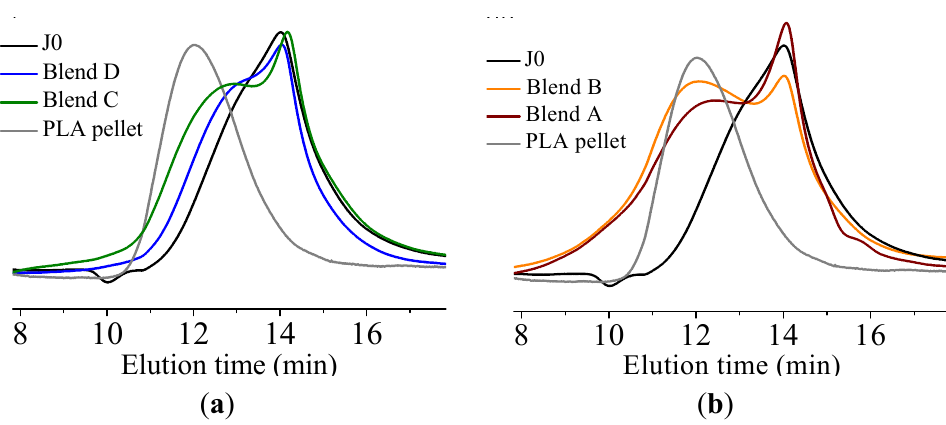
Figure 9. ( a) and ( b ): GPC traces of the